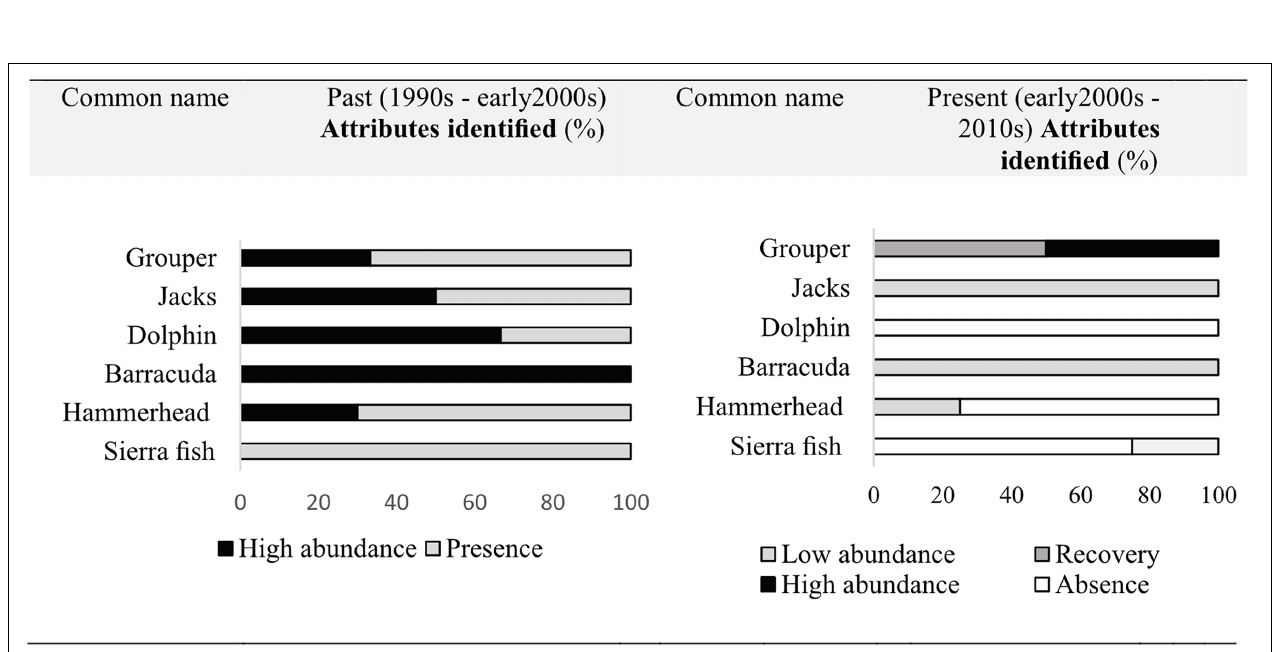
FIGURE 3 | Local ecological knowledge (LEK) about temporal changes in the state of large predatory species according to artisanal fishers consulted in the GoN (% of responses).